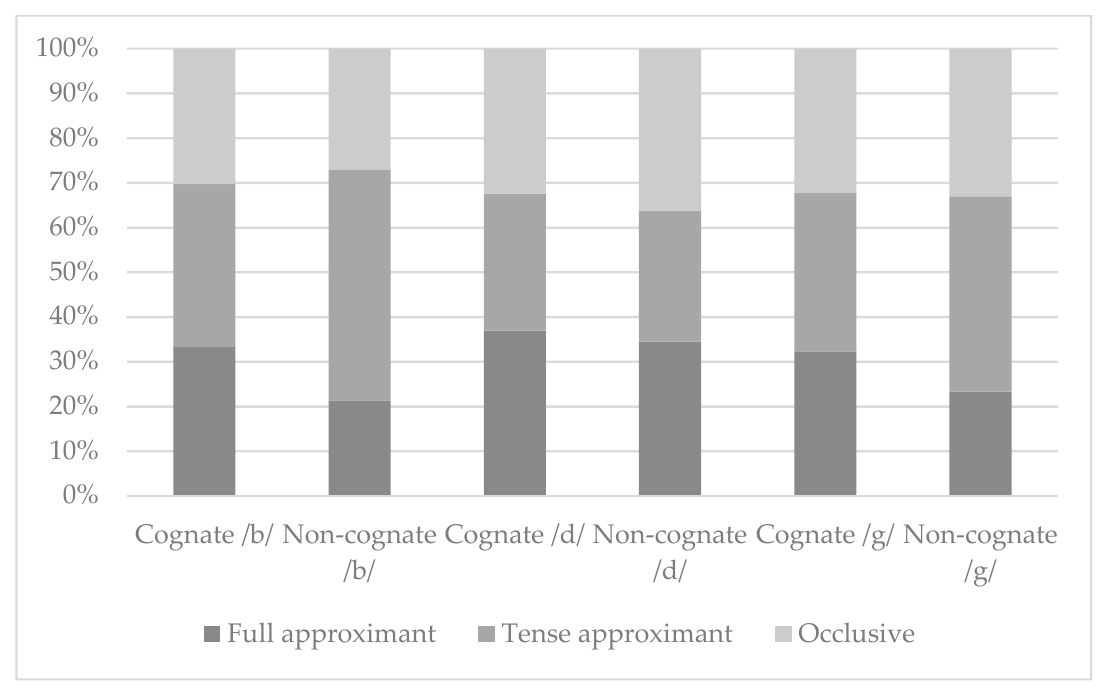
Figure 9. Rates of production types by segment in cognates and non ‐ cognates.